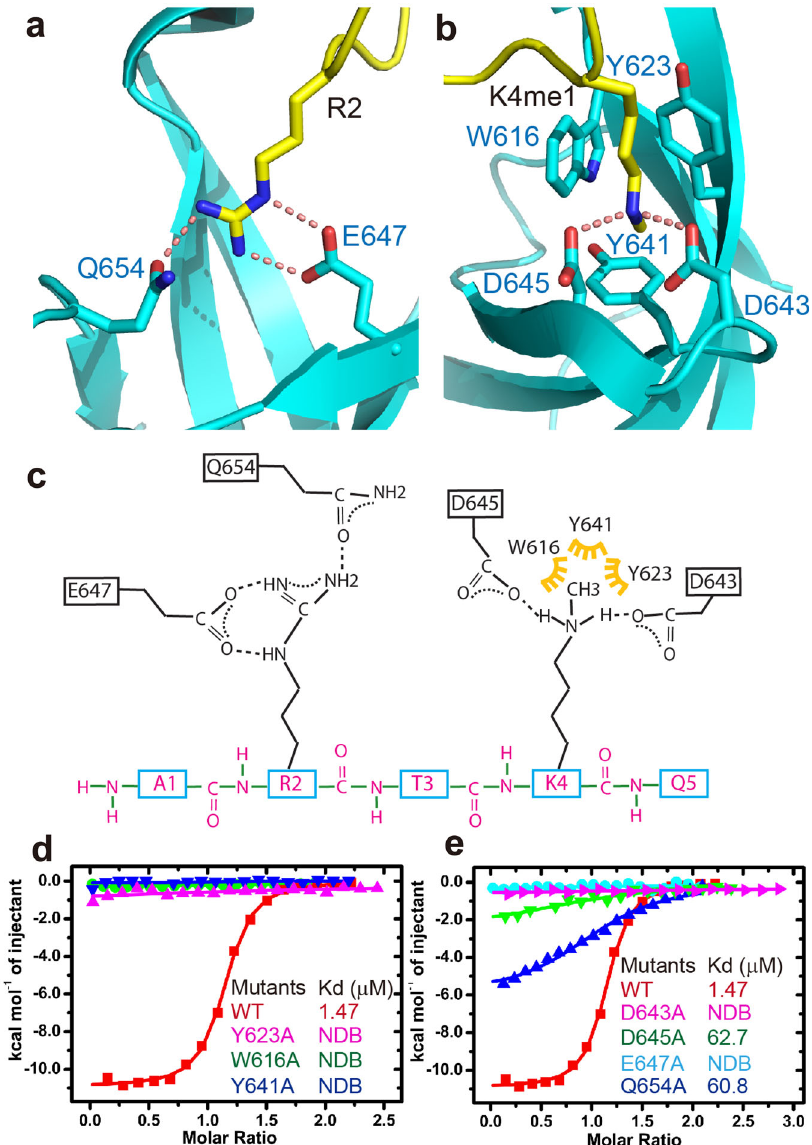
Fig. 6 Details of the speci fi c interaction between the RDM15 Tudor domain and the H3K4me1 peptide. a The side chain of H3R2 is speci fi cally recognized by Glu647 and Gln654 of the Tudor domain through a salt bridge and hydrogen-bonding interactions. The hydrogen bonds are highlighted with dashed red lines. b The methyl group of H3K4me1 is speci fi cally accommodated within an aromatic cage formed by Trp616, Tyr623, and Tyr641. The two monomethylammonium protons of monomethyllysine form hydrogen bonding and salt bridge interactions with two negatively charged Asp643 and Asp645 residues. c A schematic representation of the intermolecular interactions between RDM15 and the H3K4me1 peptide. d , e The ITC binding curves between the H3K4me1 peptide and the RDM15 Tudor domain mutations showing that the disruption of the aromatic cage ( d ) or the residues involved in hydrogen bonding interactions ( e ) dramatically decreases the binding af fi